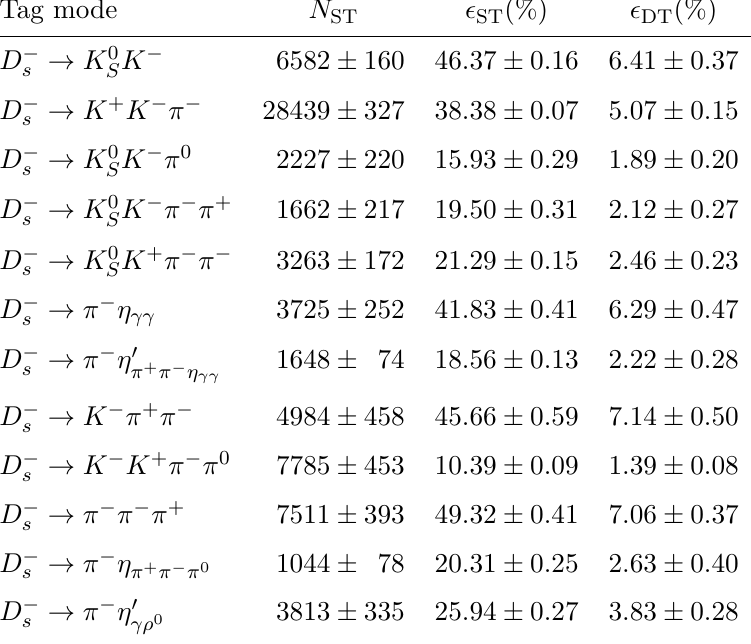
√ Table 8 . The efficiencies and ST yields at s = 4 . 226 GeV. The uncertainties are statistical. the systematic uncertainties associated with the total charged-particle tracking